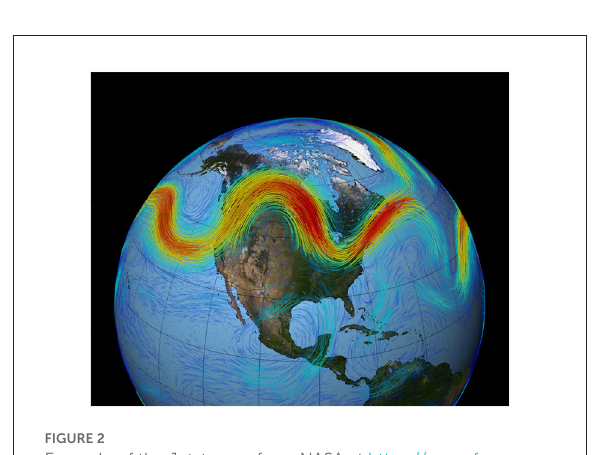
FIGURE2 Example of the Jetstream, from NASA at https://svs.gsfc.nasa. gov/3864.